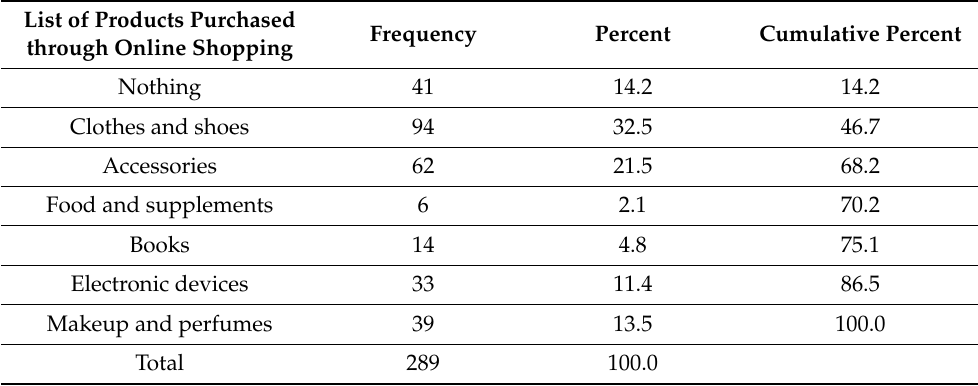
Table 3. Types of goods purchased through ONLINE